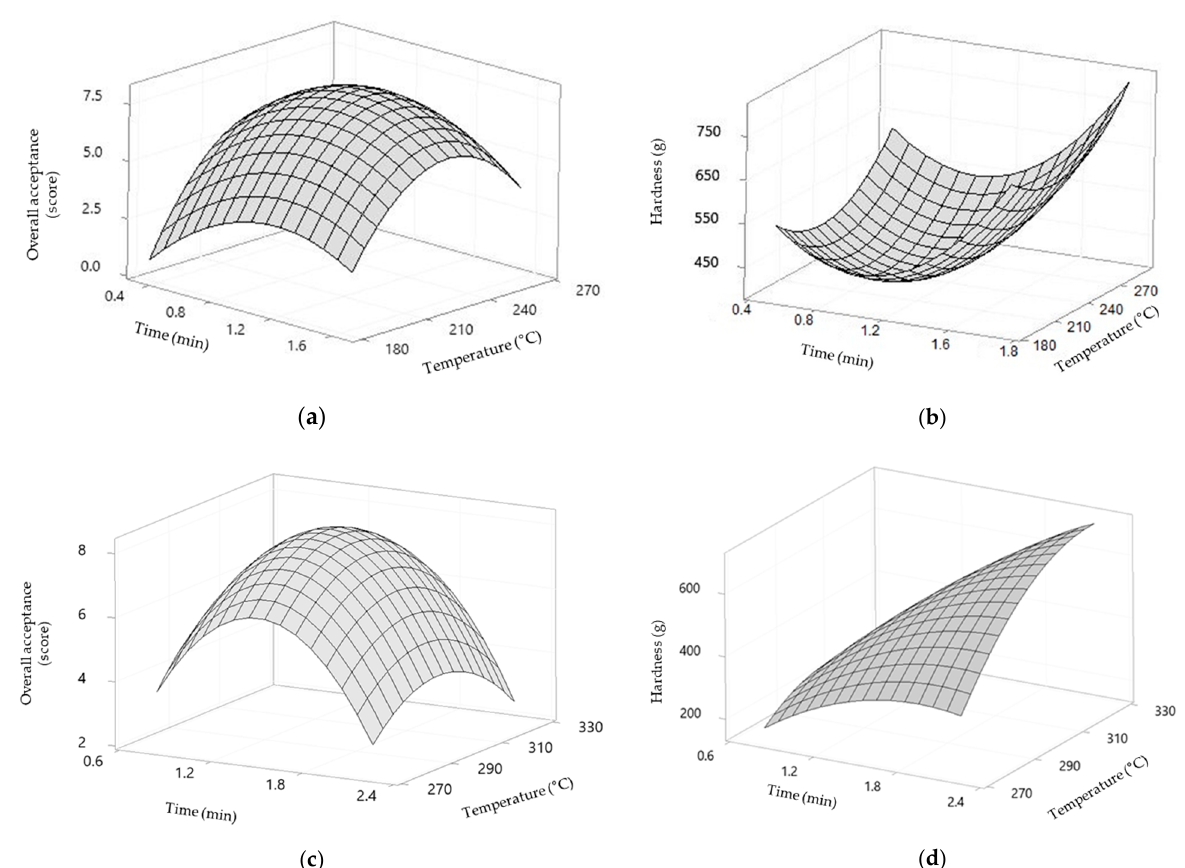
Figure 1. Three-dimensional response surface plots of overall acceptance ( a ) and hardness ( b ) of AMPS and overall acceptance ( c ) and hardness ( d ) of CSM in a superheated steam roaster using RSM.